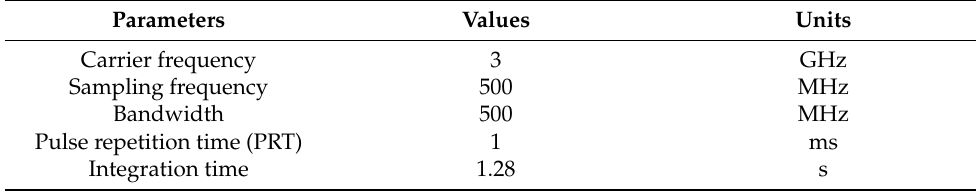
Table 1. Simulation Parameters.